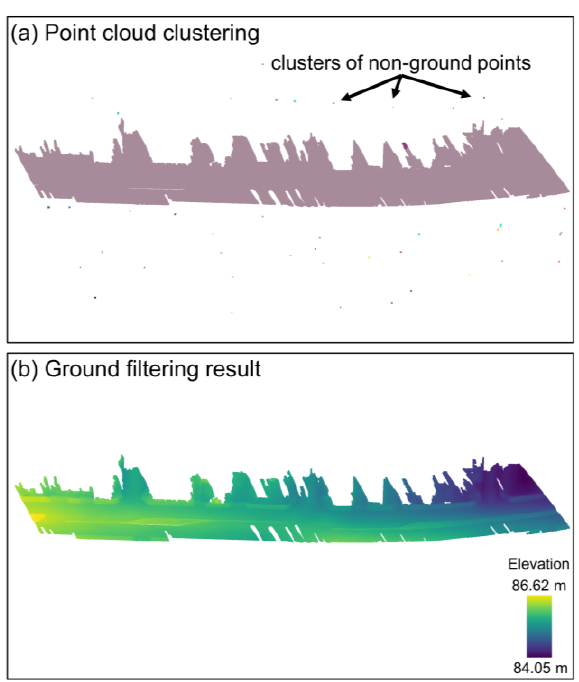
Figure 4 . Point cloud clustering and refinement result.